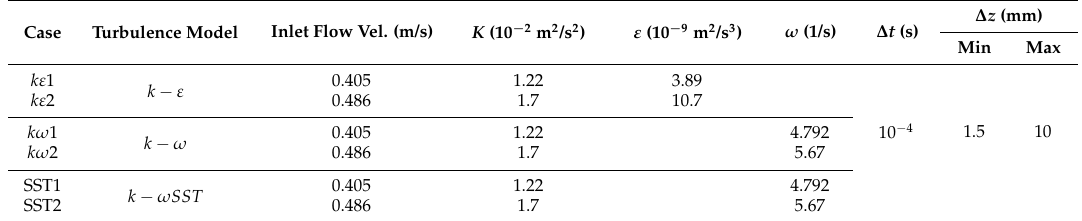
Table 3. Initial model parameters.